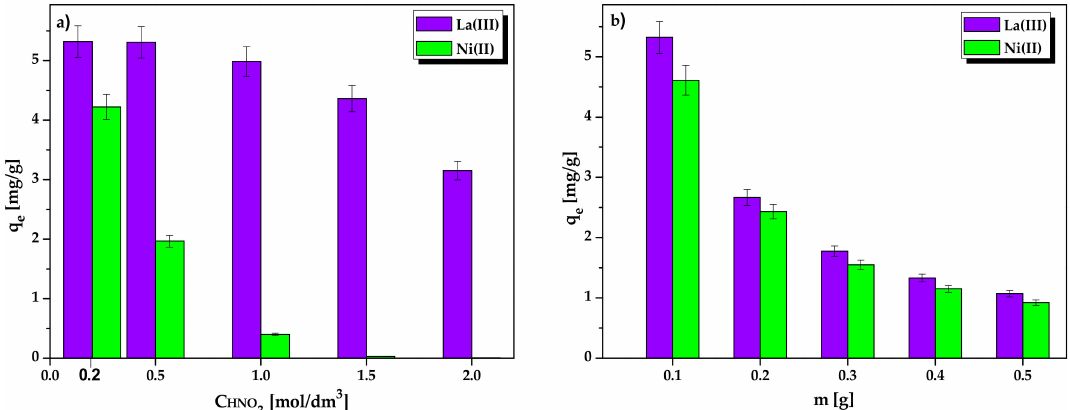
Figure 5. E ff ect of ( a ) HNO 3 concentration and ( b ) ion exchanger mass on the La(III) and Ni(II) ions sorption by Lewatit Monoplus